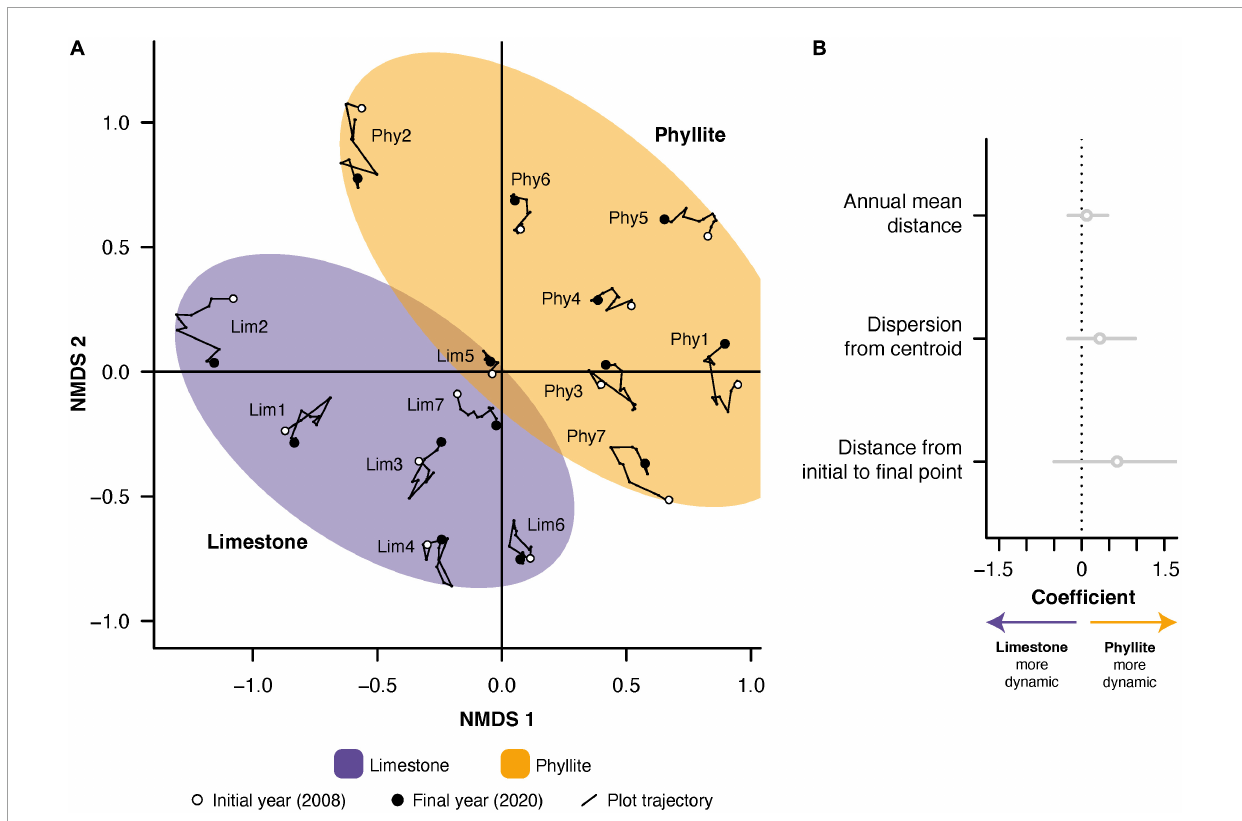
FIGURE4 Temporal trajectories of tropical dry forest (TDF) species composition recorded in permanent plots established on limestone and siliciclastic phyllite. (A) NMDS ordination based on species abundance of all annual plot observations. For each plot, lines and dots depict its 12-year long compositional trajectory; open dots represent the initial year of the trajectory (2008), and closed dots represent the endpoint (2020). Purple and yellow ellipses depict the ordination space occupied by limestone and phyllite plots, respectively. (B) Quantitative comparison of three NMDS-based metrics: “Annual mean distance” was calculated as the arithmetic average of all distances between two annual measurements in the NMDS ordination space [i.e., mean length of line segments in panel (A) ] for each substrate; “Dispersion from centroid” was calculated as the bidimensional dispersion from a plot’s centroid in the ordination space; “Distance from initial to final point” reflects the floristic difference in each plot between the initial (2008) and final (2020) points, as represented by the distance between them in the ordination space. Coefficients and their 95 % confidence intervals show the lack of significant substrate effects on the three NMDS-based metrics. See Supplementary Table 1 for a full list of the species recorded in the forest on each